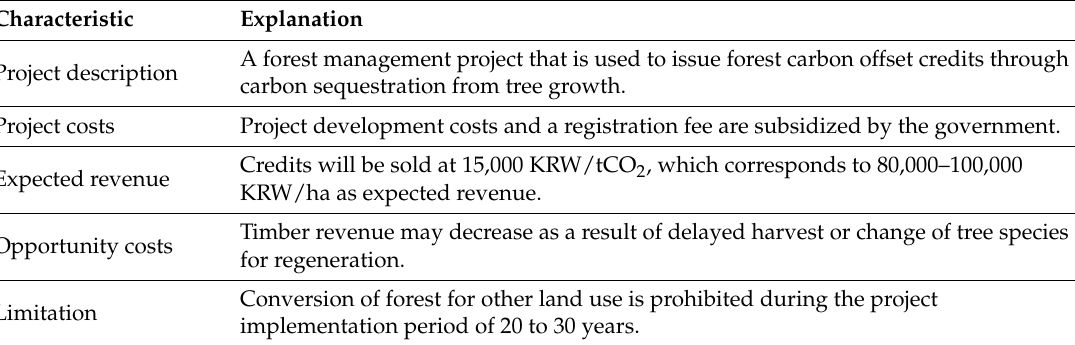
Description of the model Forest Carbon Offset (FCO) project presented to the survey